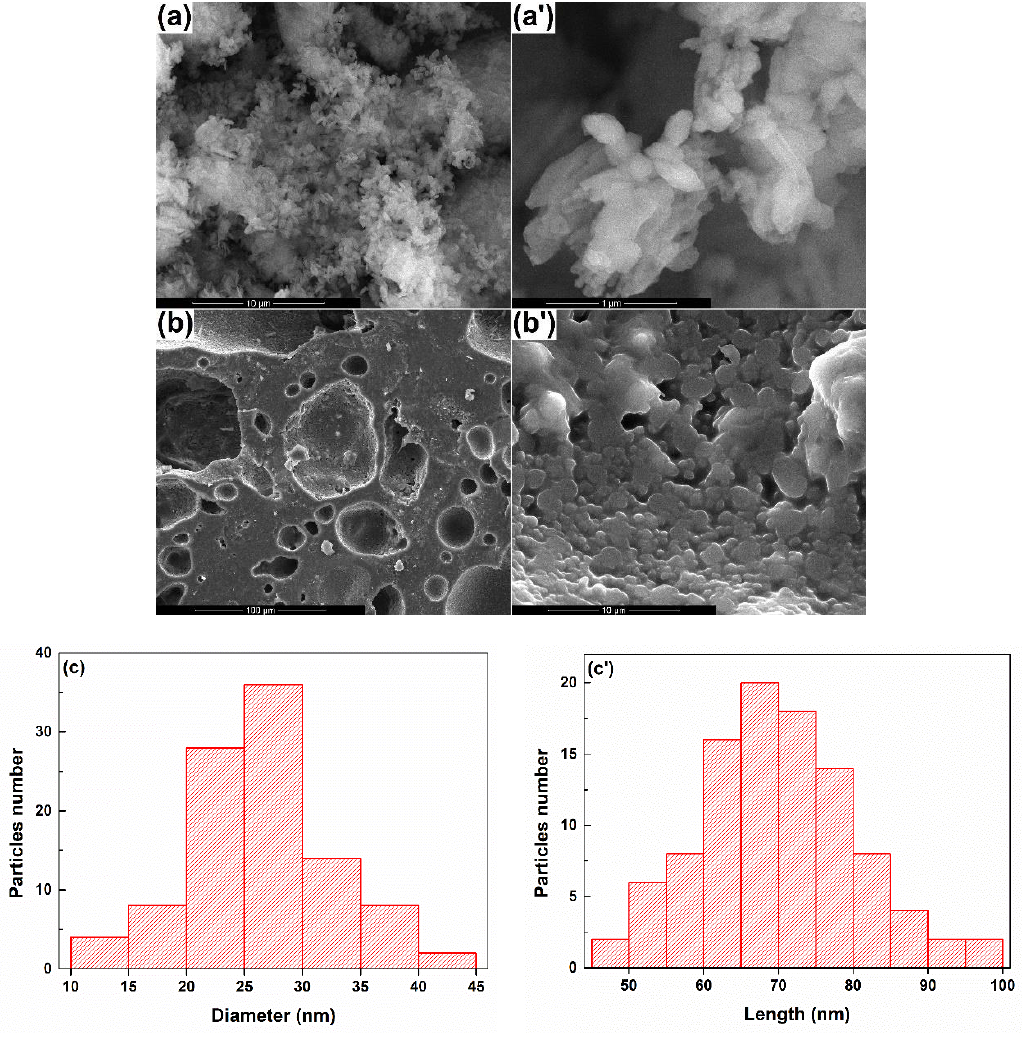
Figure 2. SEM images of: ( a -10,000× and a’ -100,000×) the powder and ( b -1,000× and b’ -10,000×) the target and ( c and c ’) statistical analyses of particles diameter and length.